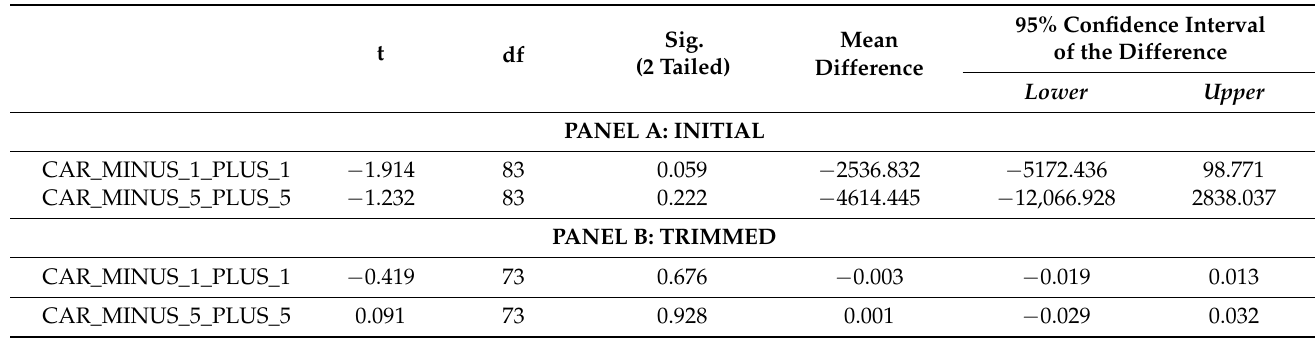
Table 6. t -test for mean difference of cumulative abnormal returns from day − 1 to day +1 and from day − 5 to day